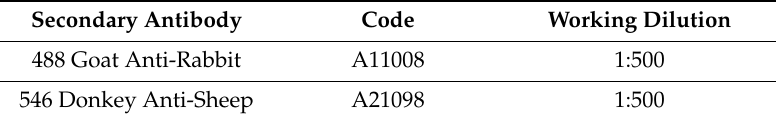
Table 2. List of the secondary antibodies used for